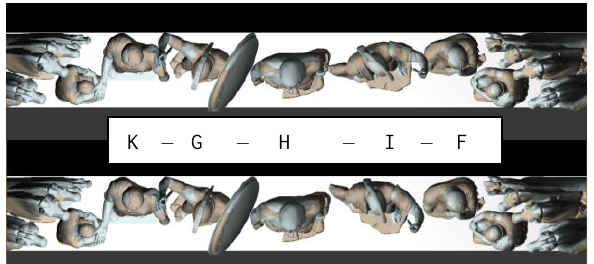
Figure 7. The same arrangement (open “A”) with figure I turned away from the rear wall (above) and parallel to it